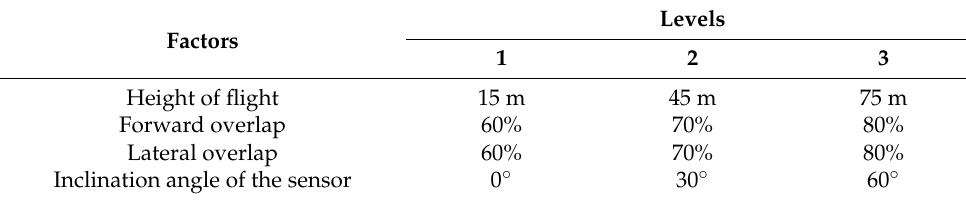
Control factors and levels for the application of Taguchi Design of Experiments (DOE) Method. Factors